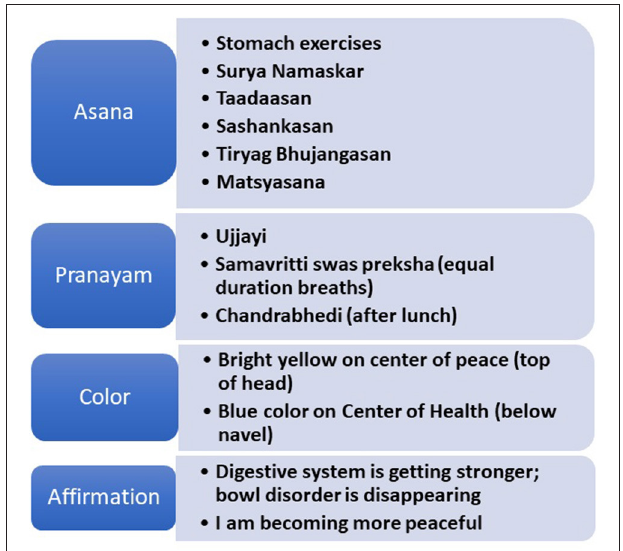
FIGURE 1 | List of poses, breathing, and medication techniques utilized during sessions. Reproduced by kind permission of Meditation ’Science’ Conferences ’LLC’ Copyrighted ’&’ proprietary ’material.